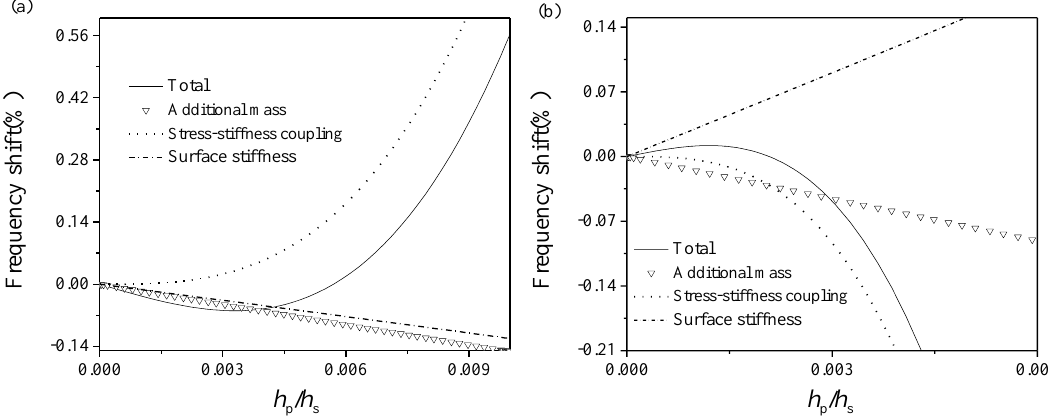
Figure 5. The first-order natural frequency shift of a hinged – hinged dsDNA-microbeam and contributions of surface stiffness ( α 1 ), stress – stiffness coupling ( α 2 ), and additional mass ( α 3 ) effects with the variation in the absolute value of film-to-substrate thickness ratio (i.e., r = | h p / h s |) in sp 6+ and NaCl solutions when the packing density η = 1.2 × 10 17 chain/m 2 . ( a ) sp 6+ solution, film-to-substrate modulus ratio g = | E p / E s | = 0.04; ( b ) NaCl solution, g = | E p / E s | = 0.1.